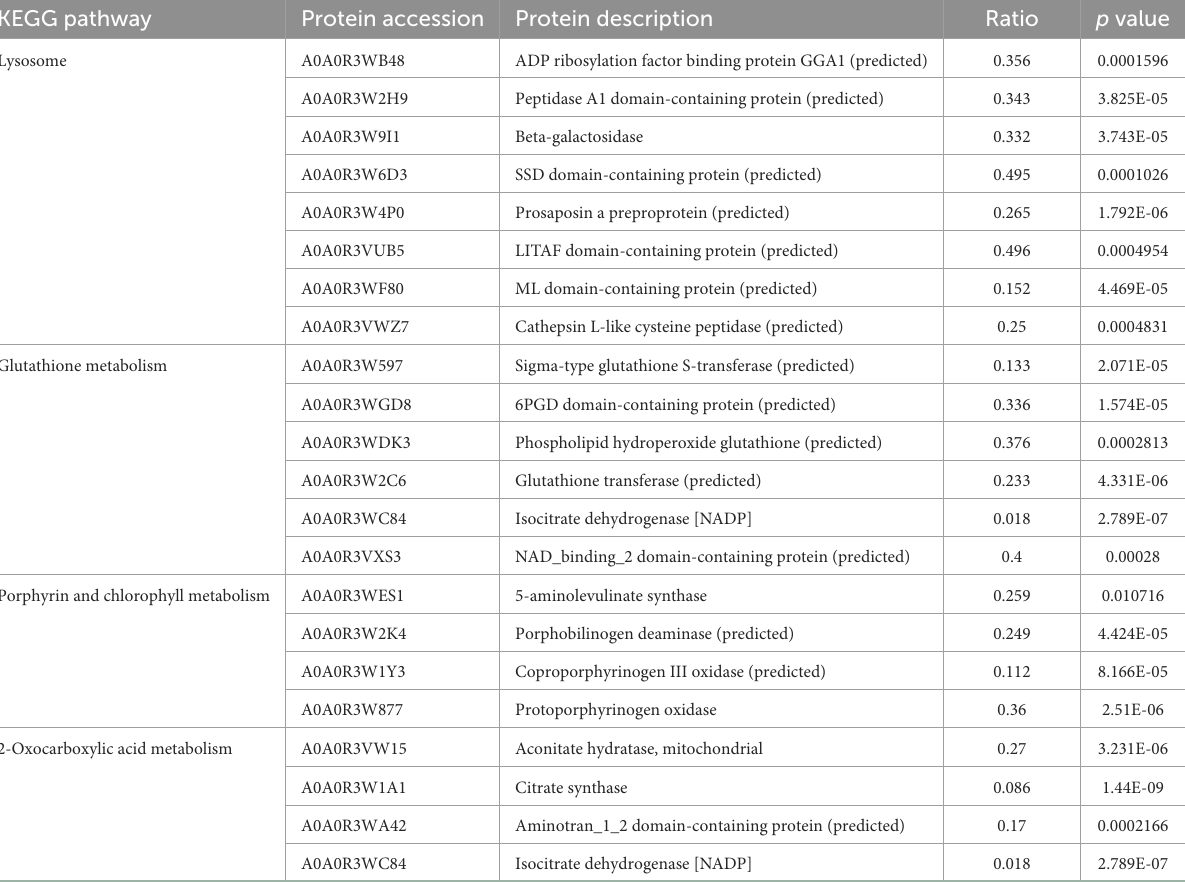
TABLE 3 KEGG enrichment of differentially expressed proteins in